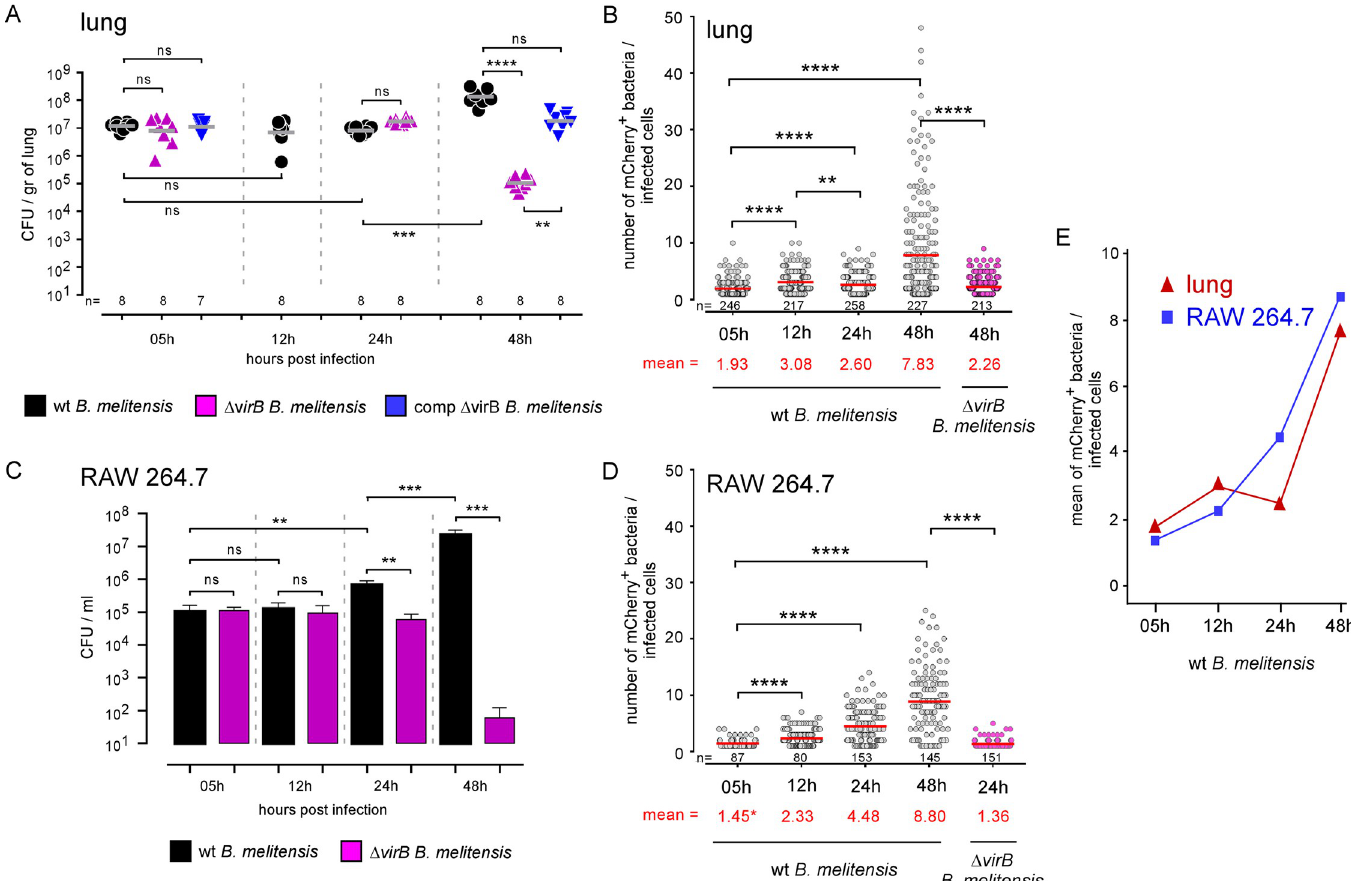
Fig 1. Comparison of B . melitensis multiplication in lungs of wild-type mice and RAW 264.7 macrophages. A, B. C57BL/6 mice (n = 7–8) were infected with 5x10 6 CFU of mCherry-expressing B . melitensis and sacrificed at the indicated time. Lungs were harvested for CFU and fluorescent microscopy analysis. Data represent ( A ) the CFU count per g of lung from individual mice (n indicates the number of mice per group) and ( B ) the number of mCherry + bacteria per cell determined by fluorescent microscopy (n indicates the number of infected cells observed per group). C, D. RAW 264.7 macrophages were infected with an MOI of 50 (50 bacteria per cell on average). Data shown are ( C ) the CFU count per condition and ( D ) the number of mCherry + bacteria per infected cell (n indicates the number of infected cells observed per group). E. Data represent the comparison of the average number of mCherry + bacteria per infected lung cell and per infected RAW 264.7 macrophage. Significant differences between the indicated groups are marked with asterisks: �� p < 0.01, ��� p < 0.001, ���� p < 0.0001, in a One-Way ANOVA with Kruskal-Wallis post-test. CFU results ( A and C ) are representative of three independent experiments. Microscopy bacteria count data for lung ( B ) are pooled from 2 independent in vivo experiment. For each experiment, the lungs of 3 mice were analyzed by fluorescence microscopy. Microscopy bacteria count data for RAW 264.7 ( D ) are pooled from 2 independent experiments.